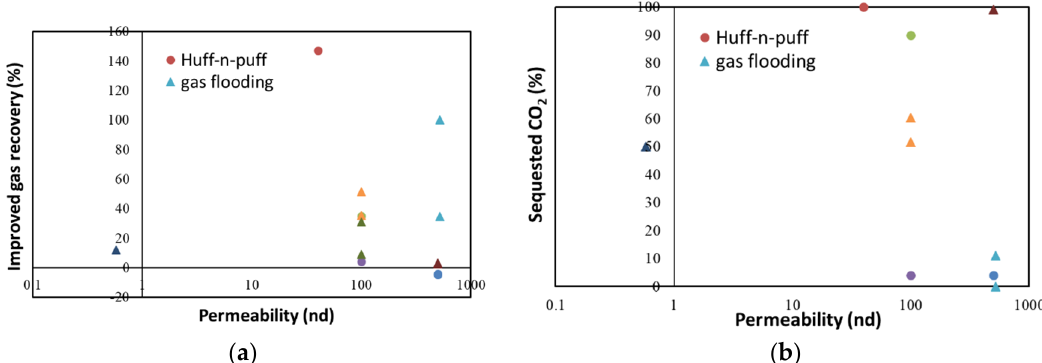
Figure 7. (a) Incremental gas recovery factor and (b) sequestrated CO 2 through huff-n-puff and gas flooding from simulation studies (Table 4), for the range of matrix permeability from 0.1 to 1000 nd. Different colors represent different simulation